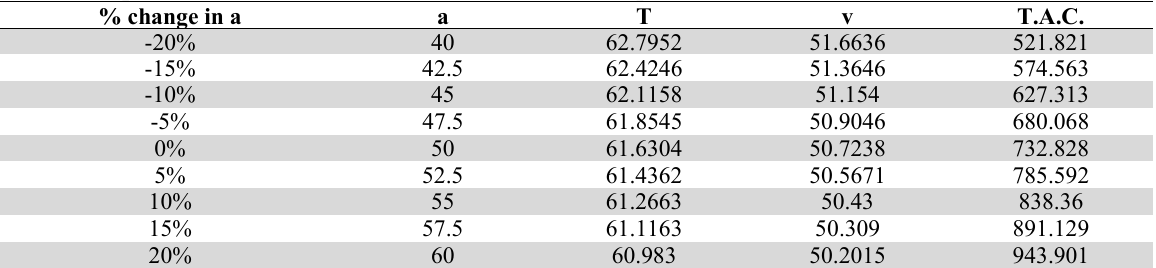
Effect on optimal solution for distinct values of demand parameter (a) % change in